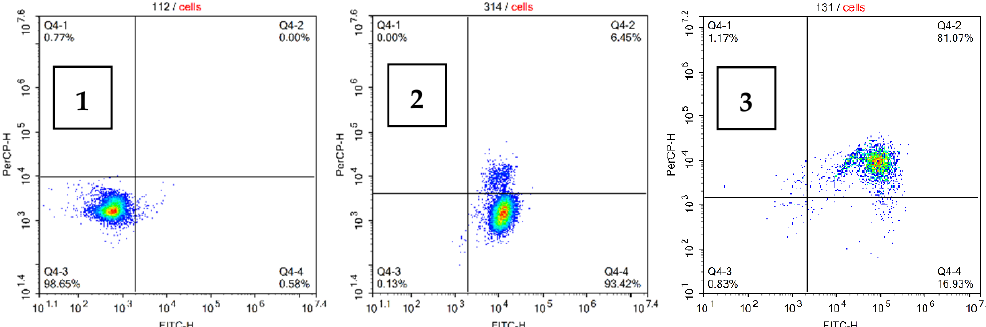
Figure 5. Detection of the phosphorylated H2A.X accumulation in the Jurkat cells exposed to compound 24d compared with etoposide. Incubation with studied compounds was carried out for 2 h. Control (live cells, unstained) ( 1 ); cells treated with compound 24d at its IC 50 concentration ( 2 ); cells treated with etoposide at a concentration of 0.2 µM/mL ( 3 ); Q4-2—cells containing phosphorylated histones H2A.X (DNA damage marker—staining with phosphor-specific antibodies Anti-phospho-Histone H2A.x (Ser139)–PerCP); Q4-3—cells without staining (live cells); Q4-4—cells containing non-phosphorylated histones H2A.X (Anti-Histone H2A.X-FITC).